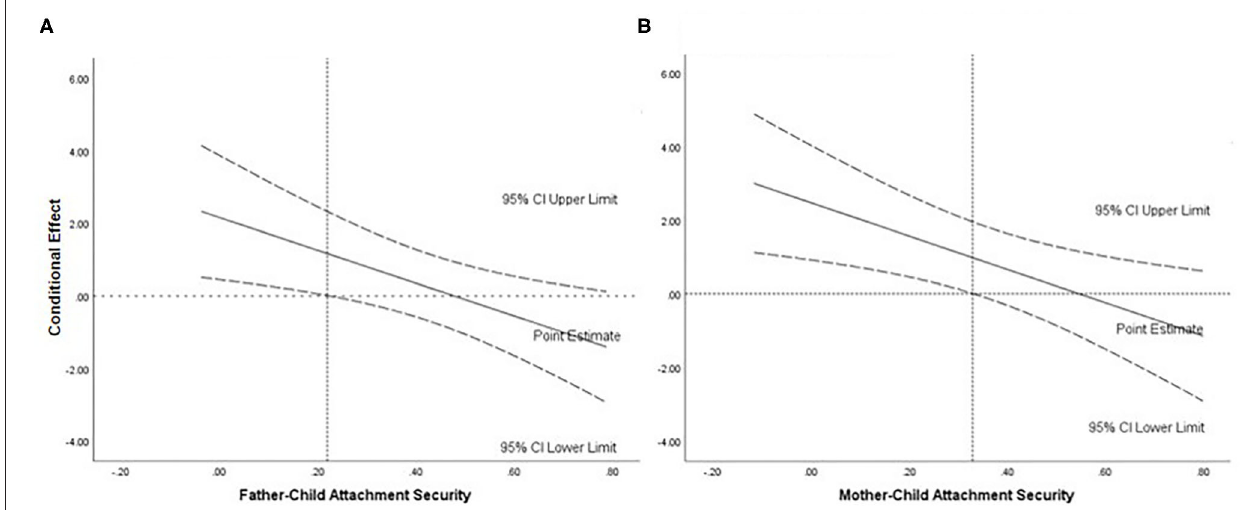
FIGURE 1 | Visual representation of the interaction of parent–child attachment security on emotion regulation. (A) Conditional effect of mother security on emotional regulation as a function of father security. (B) Conditional effect of father security on emotional regulation as a function of mother